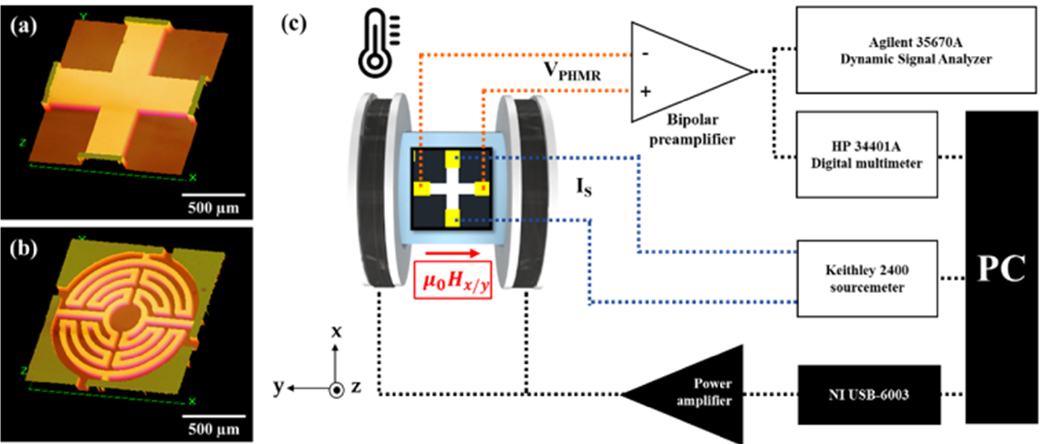
Figure 2. Optical microscopic images of ( a ) bilayer cross-type PHMR (bi-cPHMR) and ( b ) multi-ring type bi(tri) layer PHMR (mPHMR) sensor. ( c ) Schematic of the noise measurement setup, including electrical connection and the external field application ( 𝜇 (cid:2868) 𝐻 (cid:3051),(cid:3052) ).